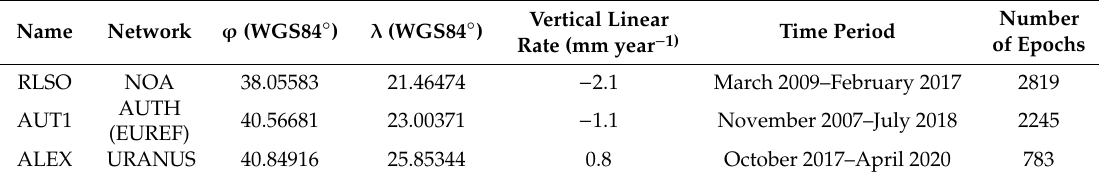
Table 2. Global navigation satellite system stations used, the date ranges, and the estimated vertical linear